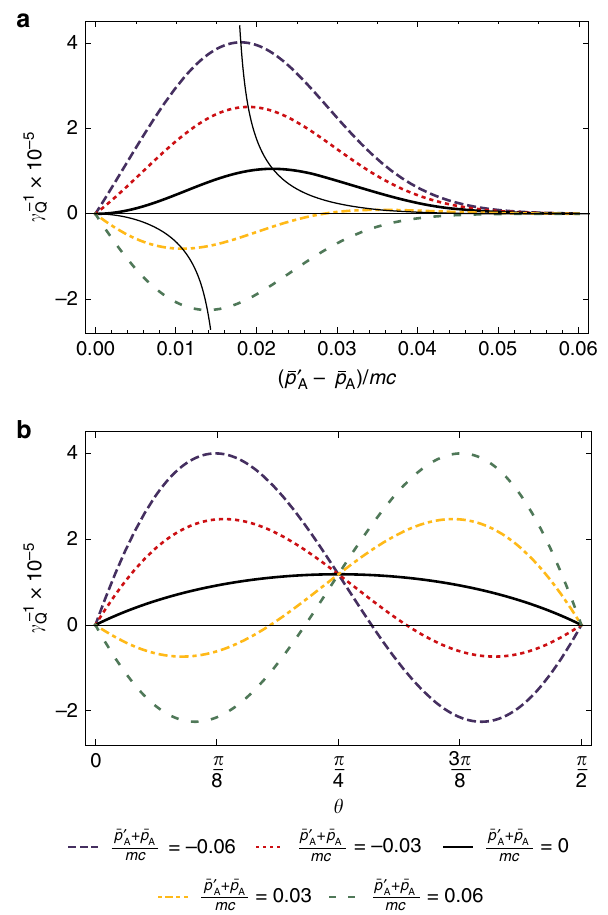
Fig. 2 Magnitude of quantum time dilation. The strength of the quantum time dilation effect γ (cid:2) 1 is plotted in a as a function of the momenta Q (cid:2) (cid:2) p Þ = mc , where (cid:2) p ¼ ð (cid:2) p ; 0 ; 0 Þ and (cid:2) p 0 ¼ ð (cid:2) p 0 ; 0 ; 0 Þ denote difference ð (cid:2) p 0 A A A A A A the average momentum of the wave packets comprising the superposition state in Eq. (22) for θ = π /8, and in b as a function of superposition weight θ for ð (cid:2) p 0 (cid:2) (cid:2) p Þ = mc ¼ 0 : 17. Different values of the average total momentum A A ð (cid:2) p 0 þ (cid:2) p Þ = mc are shown and Δ mc = 0.01 in all cases. The thin black line A / A A in plot a traces the trajectory of the optimal momentum difference (cid:2) p opt for (cid:16) (cid:17) þ (cid:2) p = mc different total momentum (cid:2) p 0 A A